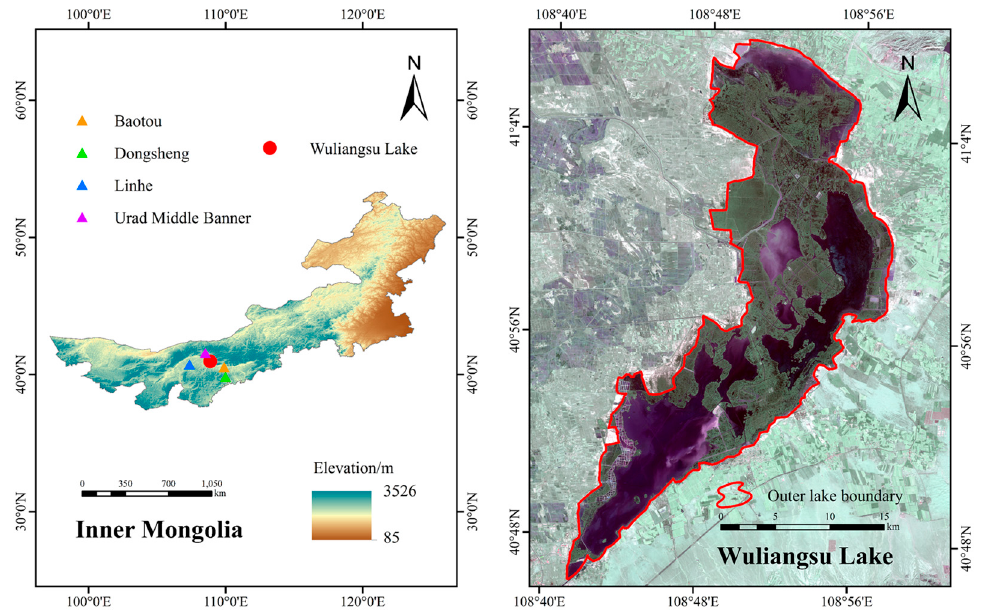
Figure 1. Location of the Wuliangsu Lake (the image on the right is the Sentinel-2’s imagery on 2 November 2020, the outer lake boundary contains lake water and extensive aquatic plants).